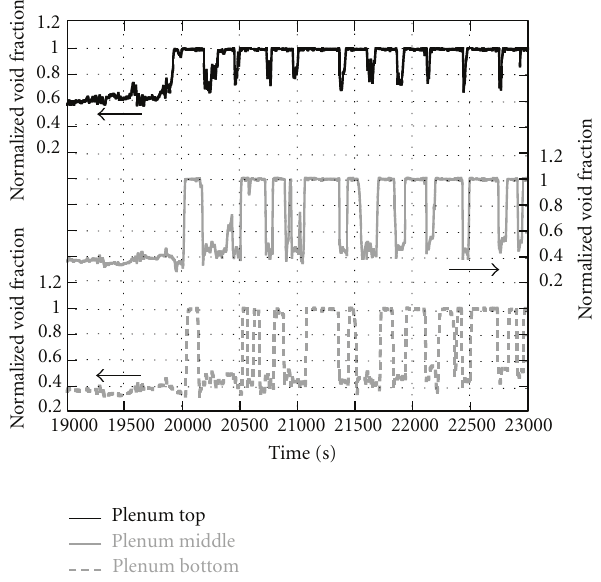
Figure 30: RELAP5 results for void fraction at top, middle, and bottom of SG inlet plenum in loop with